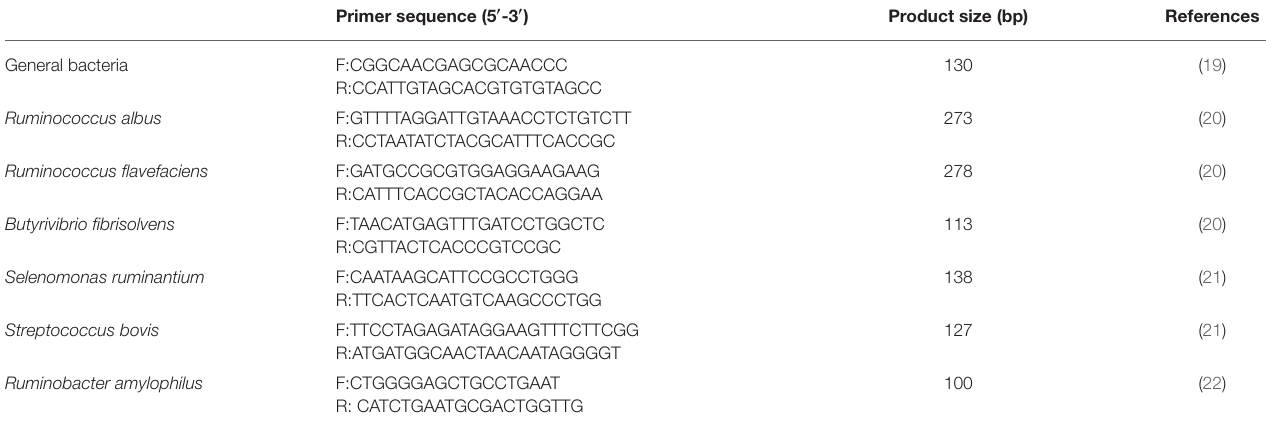
TABLE 2 | Primers used for real-time PCR